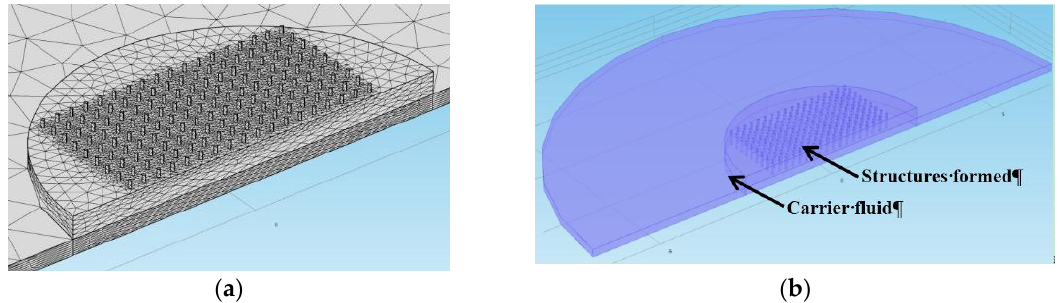
Figure 11. Images taken from the COMSOL model interface ( a ) mesh (centered on the center of the electrode); and ( b ) geometry.